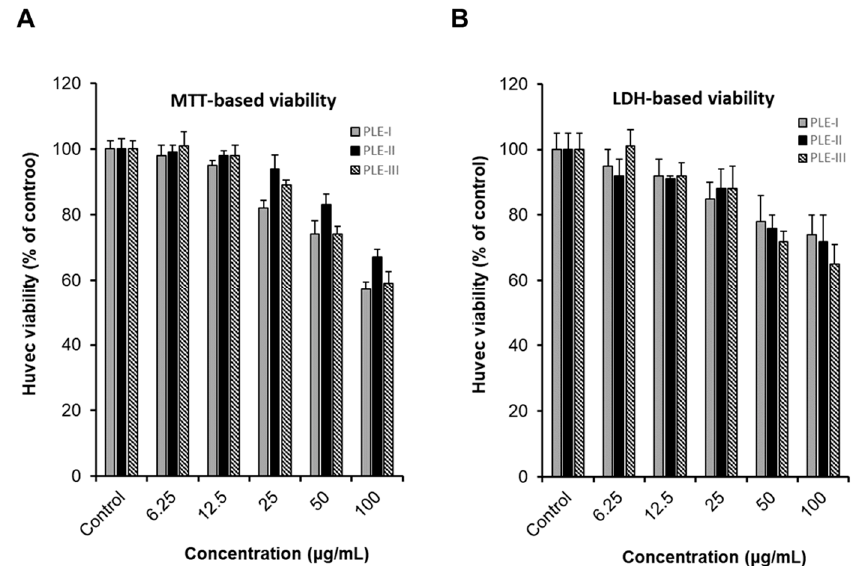
Figure 2. The cytotoxic effect of PLE-I–III on human umbilical vein endothelial cells (HUVECs). Com- parison of the effect of PLE-I–III polysaccharide fractions on HUVEC proliferation and assessment of cytotoxicity. The cells were treated with the indicated concentrations of PLE-I–III for 24 h, and then, cell viability was evaluated using the EZ-Cytox reagent ( A ) or LDH reagent ( B ). The cells in the control group were treated only with media.